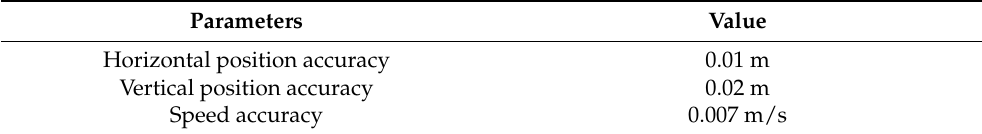
Table 2. Accuracy of the